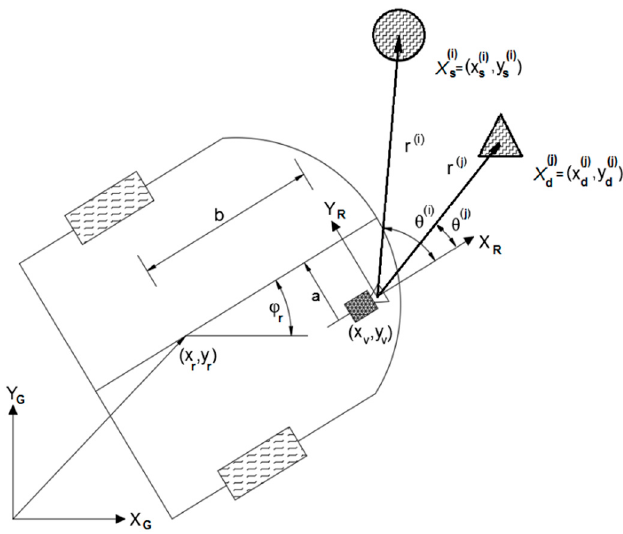
Figure 4. Vehicle and observation kinematics [38].